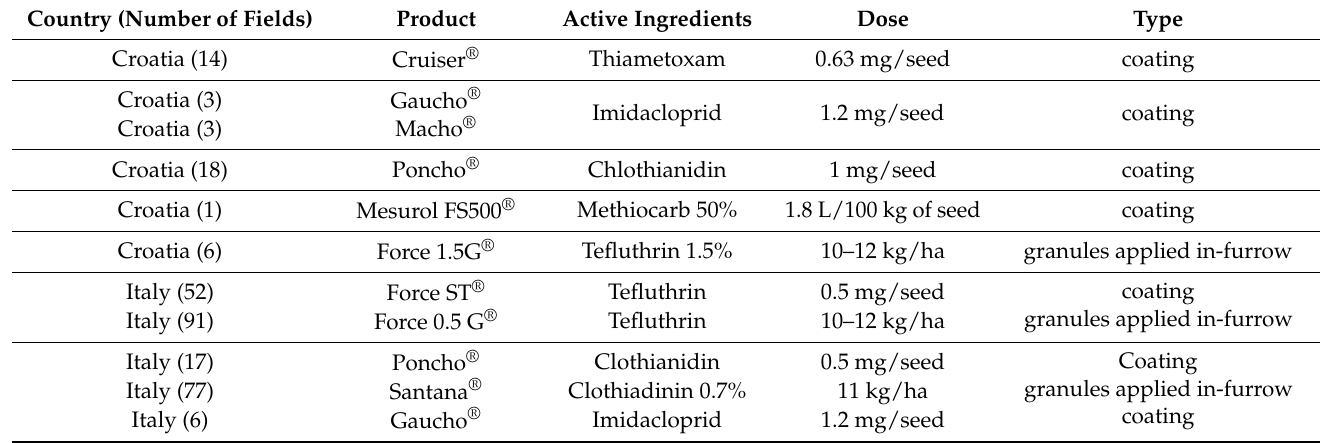
Table 2. List of soil insecticides used on the fields during the years of